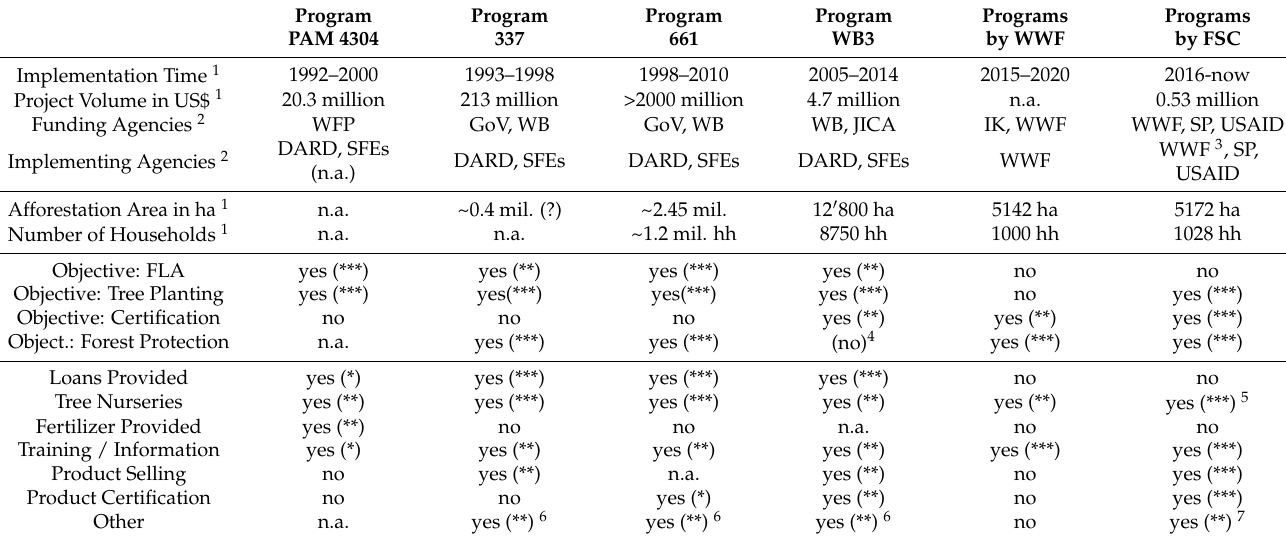
Table 3. Summary of key data and characteristics of plantation programs listed by the respondents. The table indicates the programs’ objectives and items of investment in terms of relatively major (***), medium (**) and minor (*) importance. In some cases, information could not be found from available resources